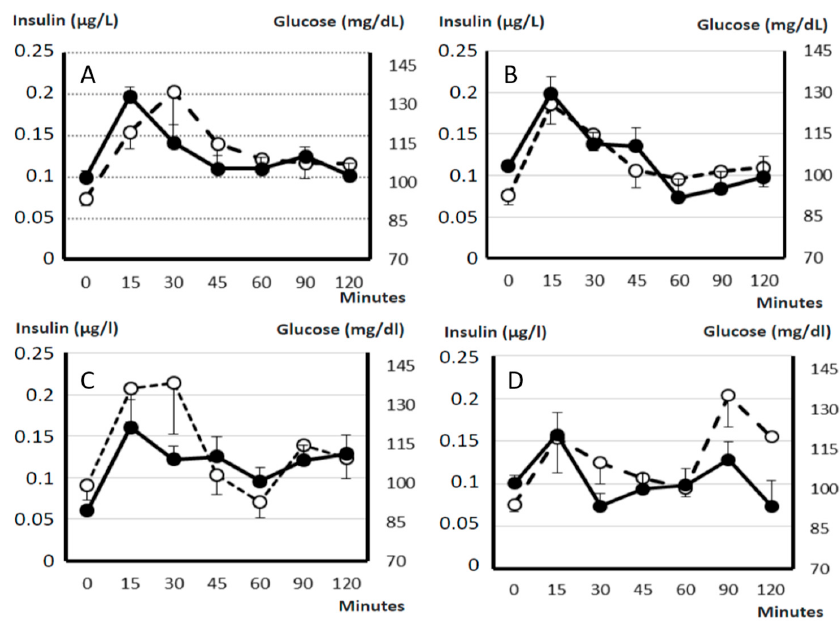
Figure 5. Changes in plasma concentration of glucose (continuous line with black circles) and insulin (discontinuous line with white circles) over time after oral administration of 2 g/kg live weight of D -glucose in control sows ( A ; n = 17) and at 0 ( B ), 45 ( C ) and 90 days ( D ) after starting differential feeding with a diet enriched with saturated fat in treated sows ( n = 11). Areas under the Curve (AUCs) for glucose and insulin were similar in control and treated sows at Day 0. AUCs for glucose remained almost stable at 45 and 90 days but AUCs for insulin increased and were higher at both Day 45 and 90 than at Day 0 ( p < 0.01 and p < 0.05, respectively).